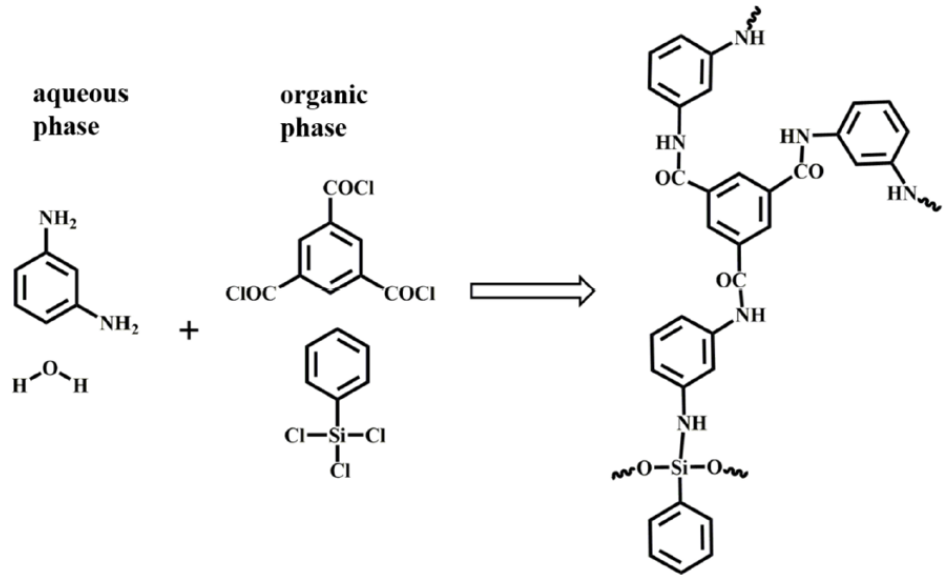
Figure 2. Interfacial polymerization process.